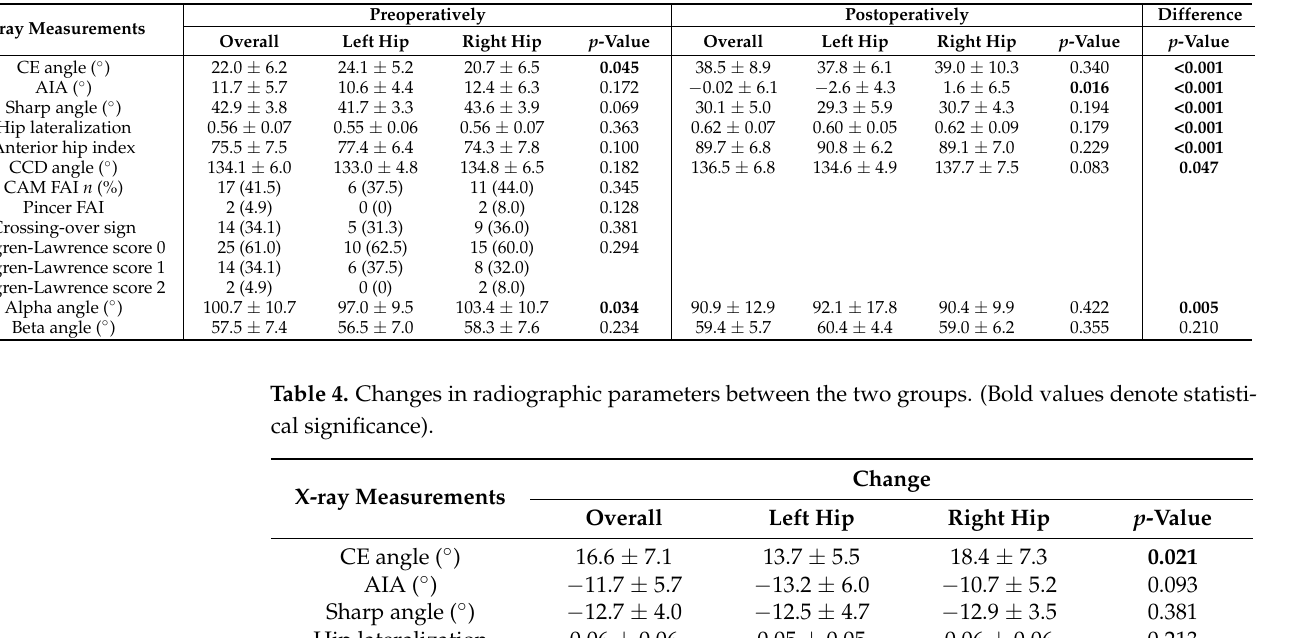
Table 3. Radiographic findings pre and postoperatively include significant differences between the individual groups. (Bold values denote statistical significance).